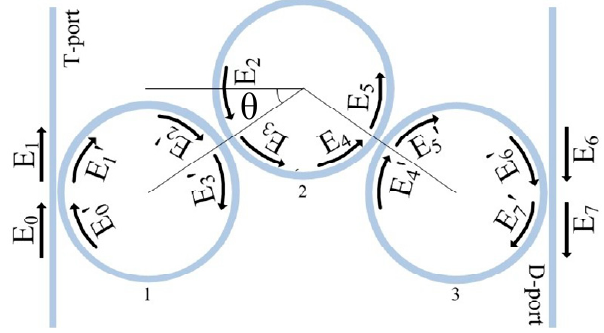
Figure 1. Schematic of three-ring coupled resonator.